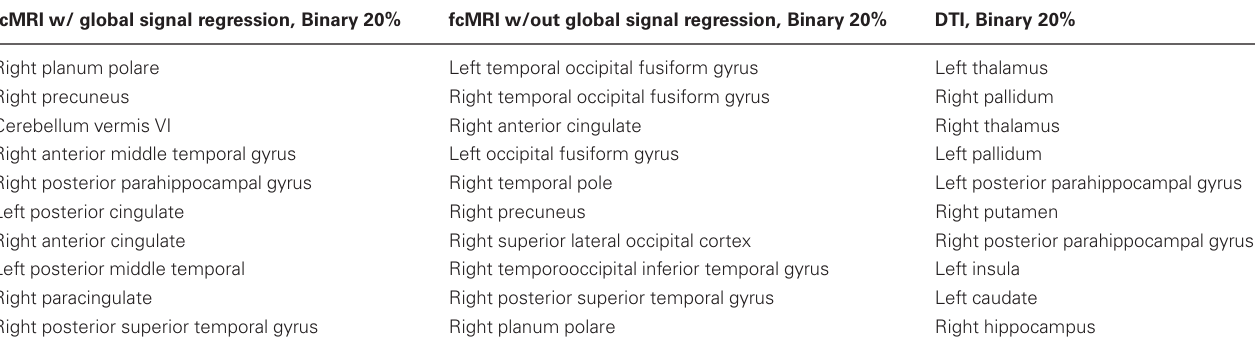
Table 3 | Regions with the highest combined rank for node strength, betweenness centrality, and regional efficiency, based on fcMRI/DTI networks binarized and thresholded to keep the 20% strongest